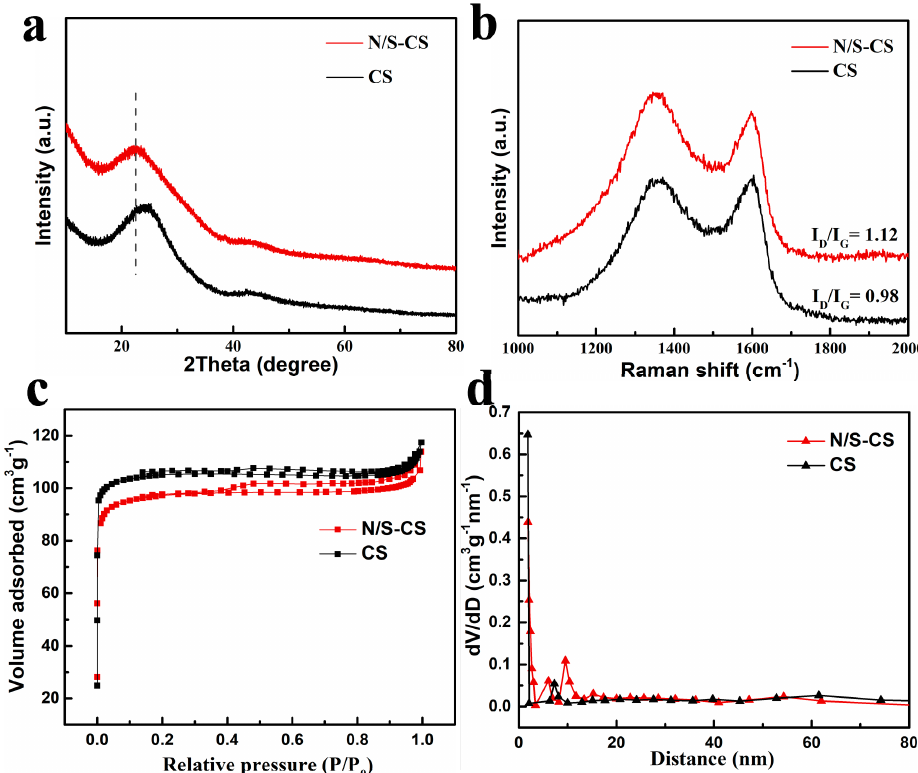
Figure 2. ( a ) XRD patterns of N/S ‐ CS and CS; ( b ) Raman spectra of N/S ‐ CS and CS; ( c ) Nitrogen adsorption/desorption isotherms of N/S ‐ CS and CS; ( d ) Pore size distribution curves of N/S ‐ CS and CS.